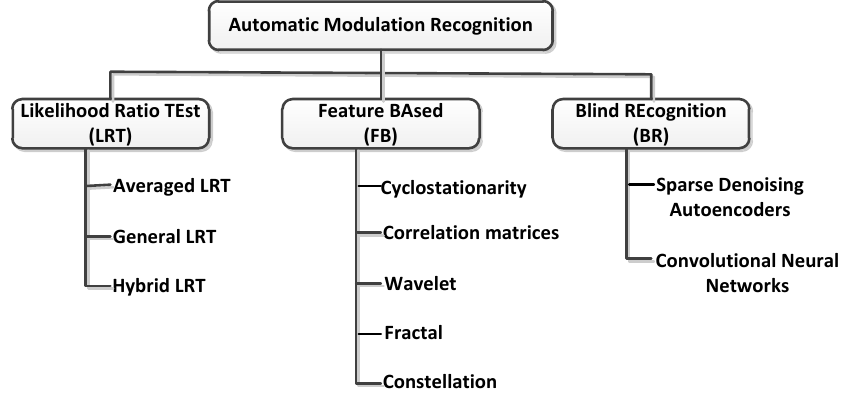
Figure 1. Main implementation of modulation classification.